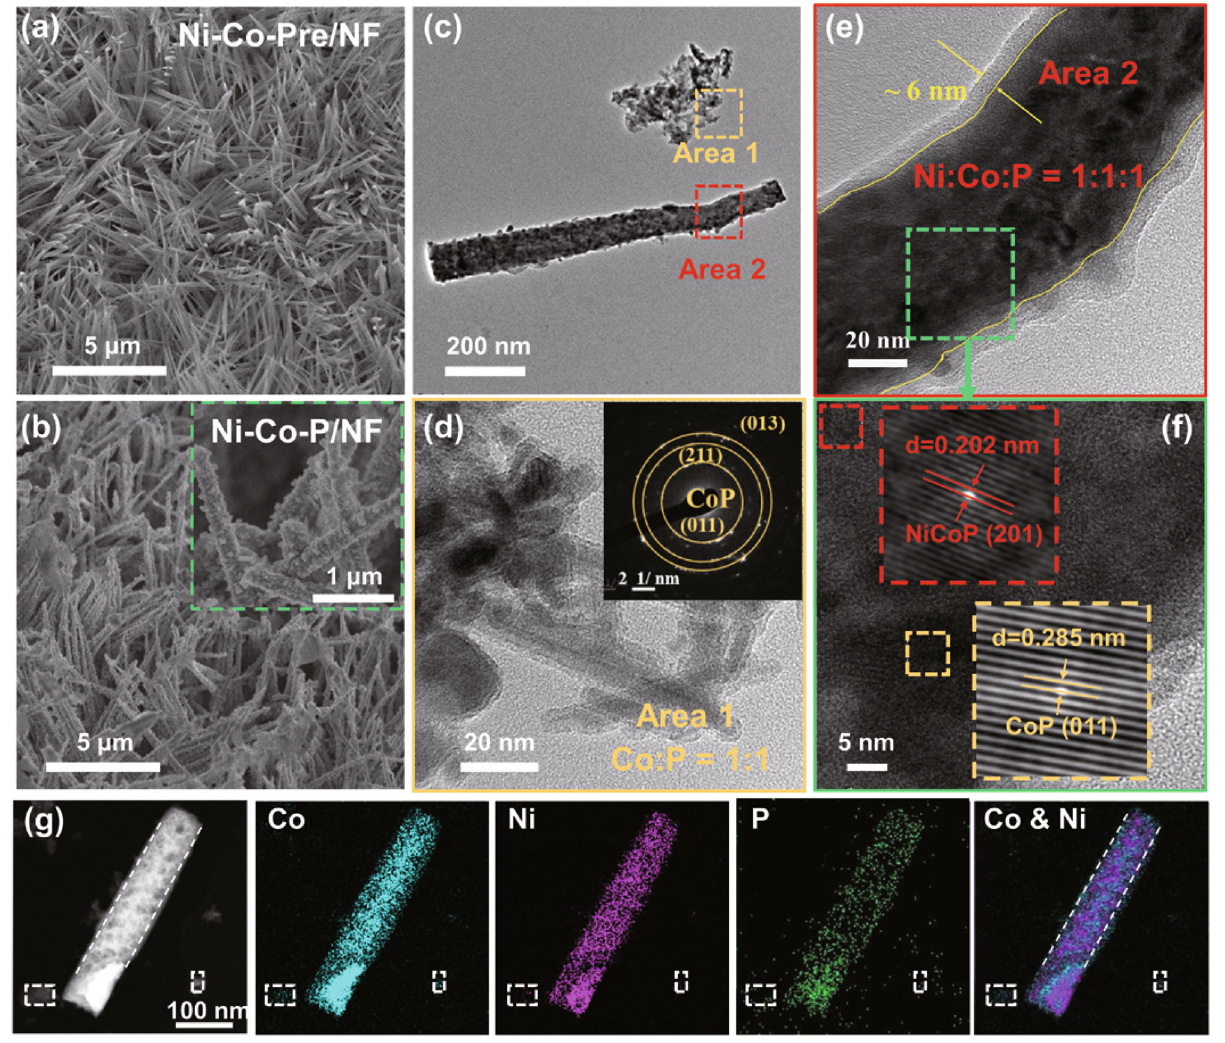
Fig. 1 | Morphological characterizations of Ni-Co-P/NF and reference samples. SEMimagesof a Ni-Co-Pre/NFand b Ni-Co-P/NFwithamagni fi edimageintheinset; c TEM image of Ni-Co-P/NF, in which the squared Area 1 and Area 2 are magni fi ed